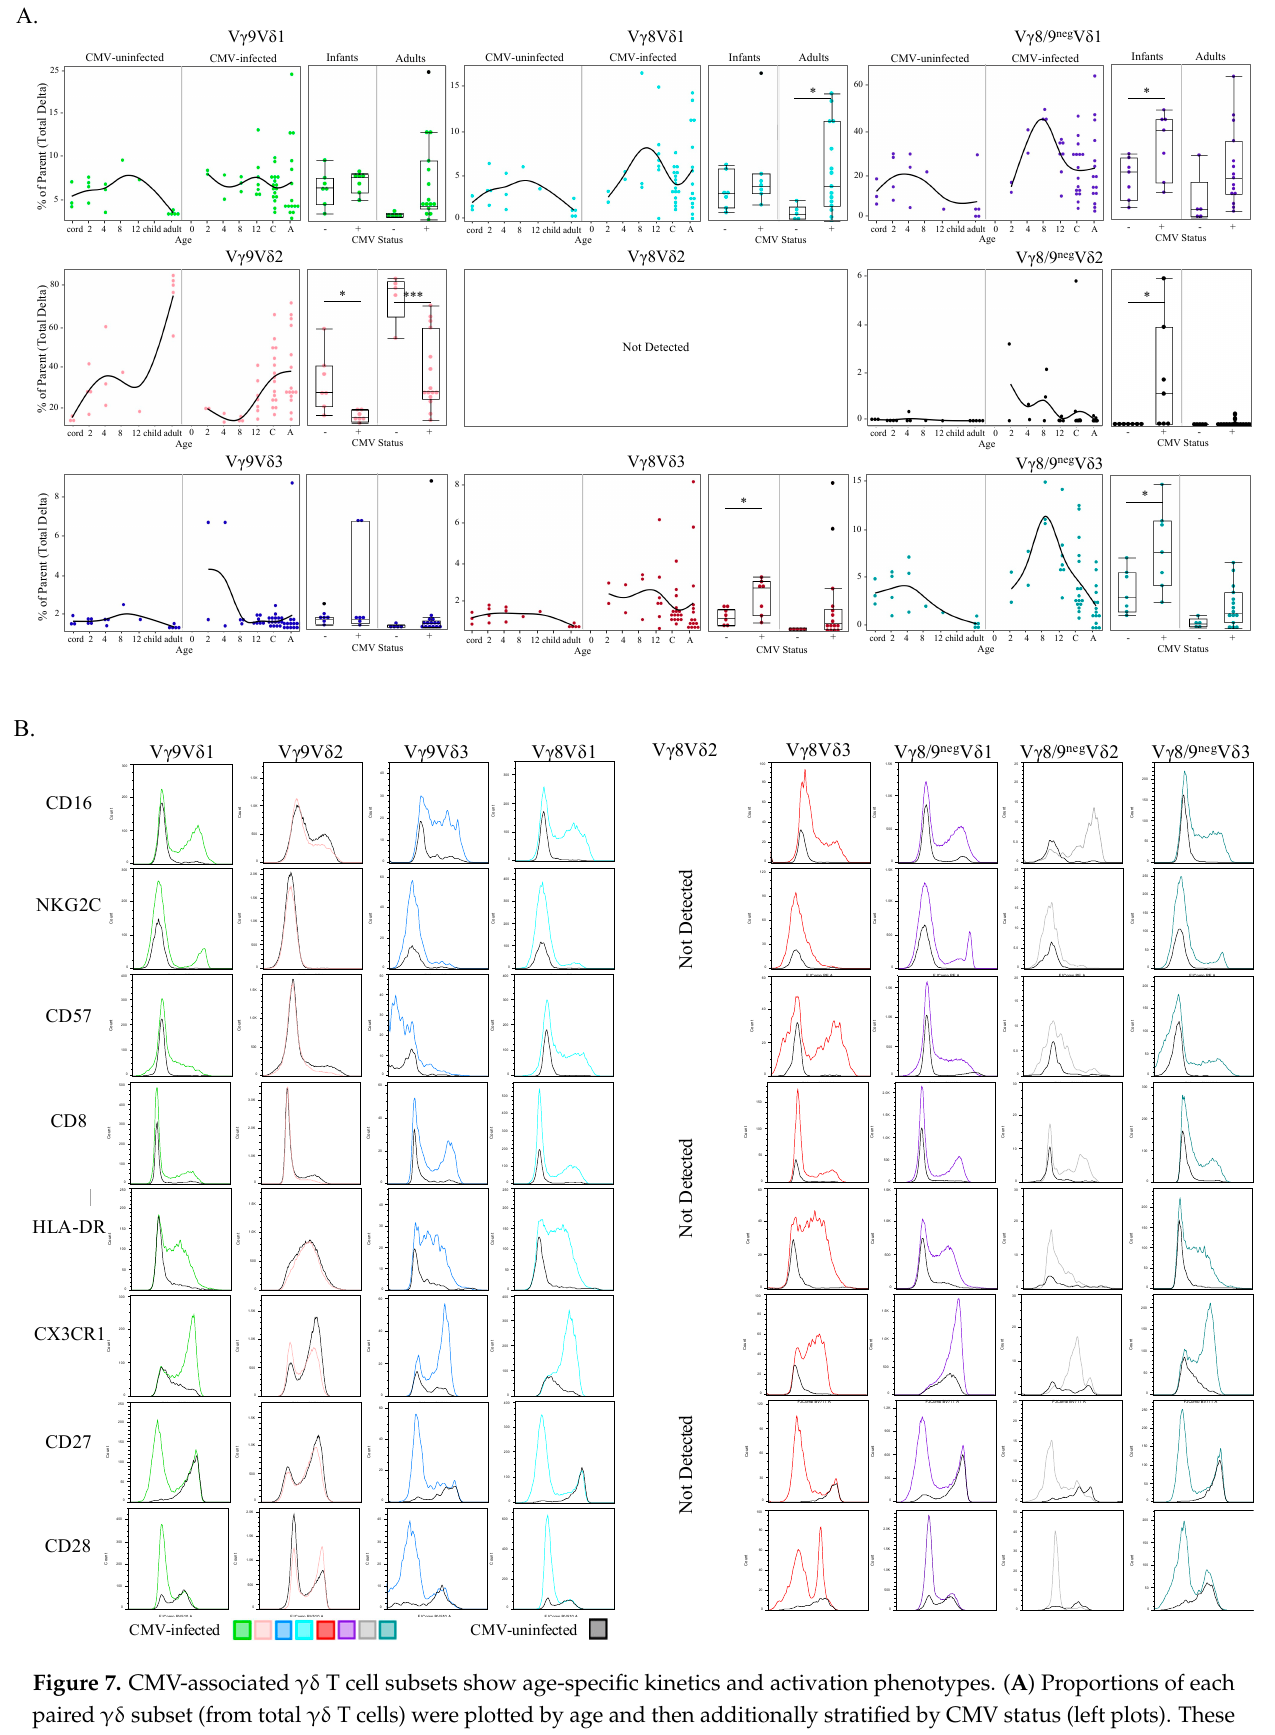
Figure 7. CMV-associated γδ T cell subsets show age-specific kinetics and activation phenotypes. ( A ) Proportions of each paired γδ subset (from total γδ T cells) were plotted by age and then additionally stratified by CMV status (left plots).